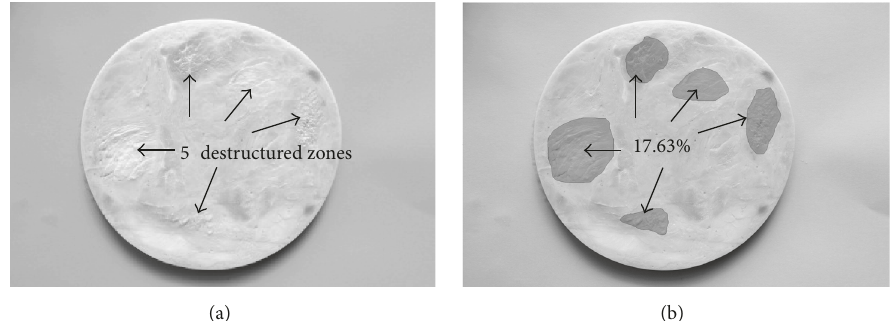
Figure 1: The cut surface of a cooked ham with determination of the number of destructured zones (a) and the total area of these zones